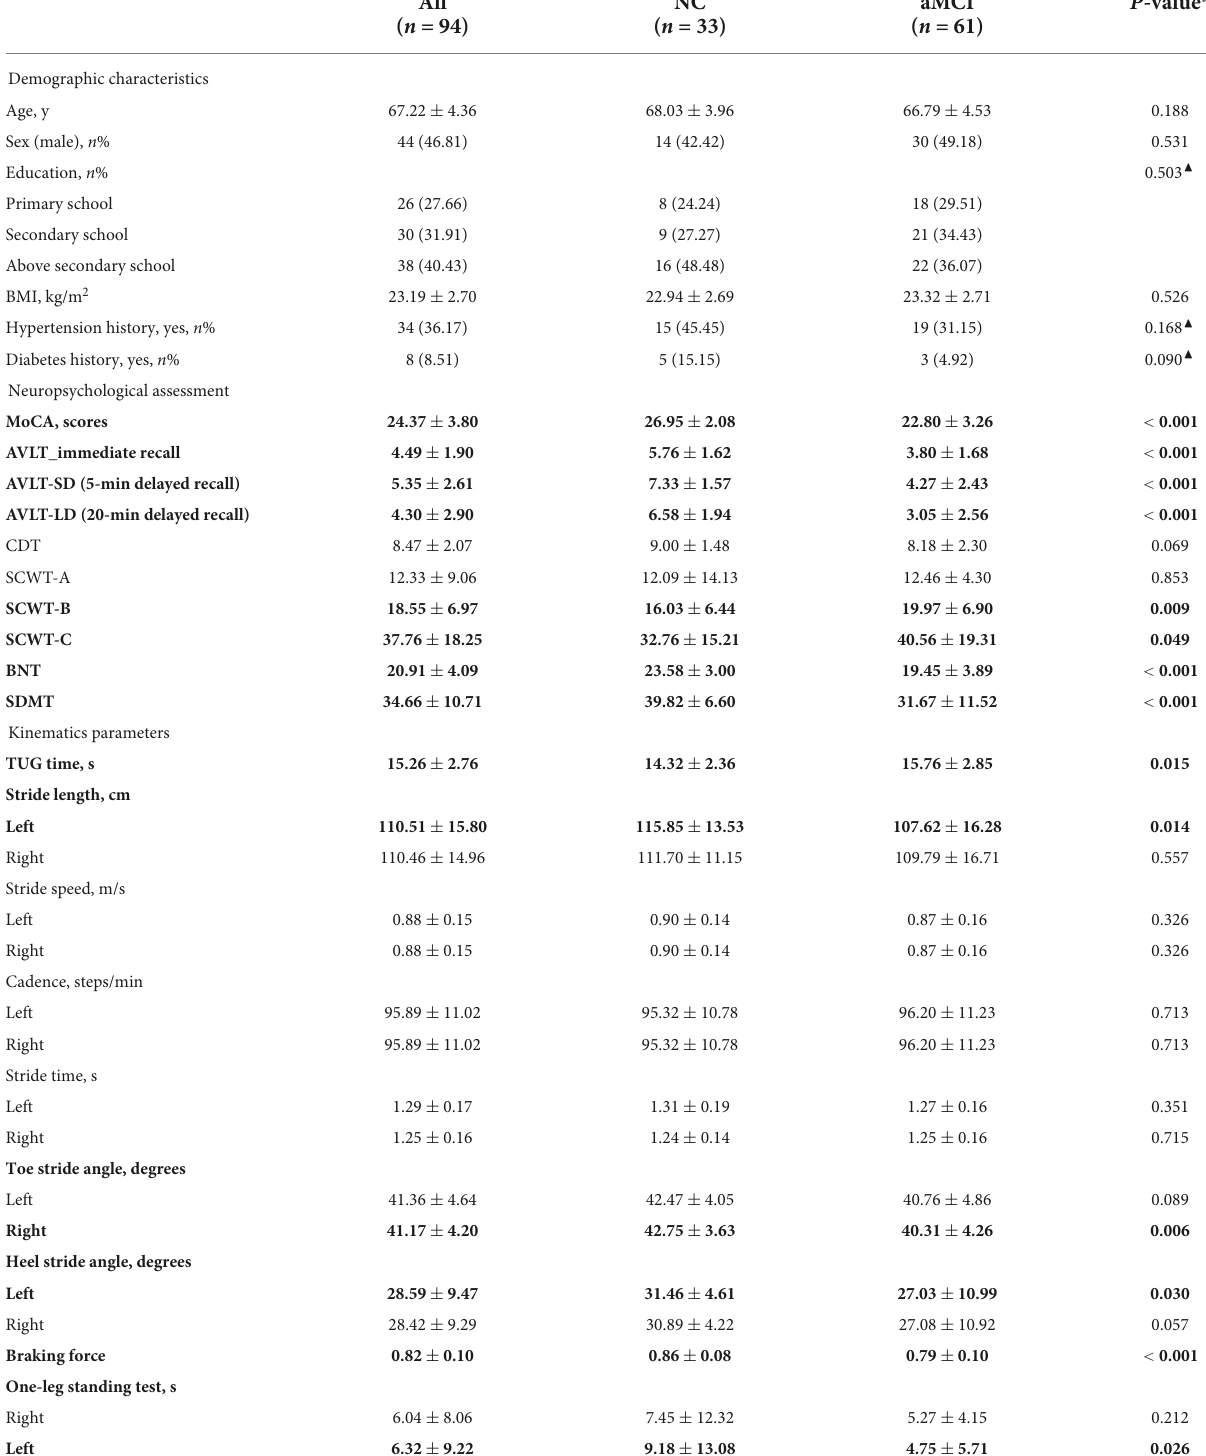
TABLE 1 Characteristics of the study